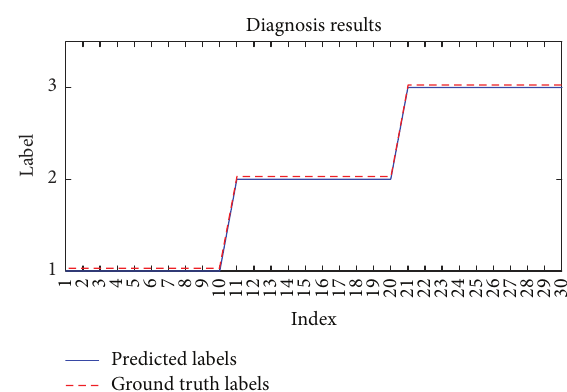
Figure 7: Classification results of the testing